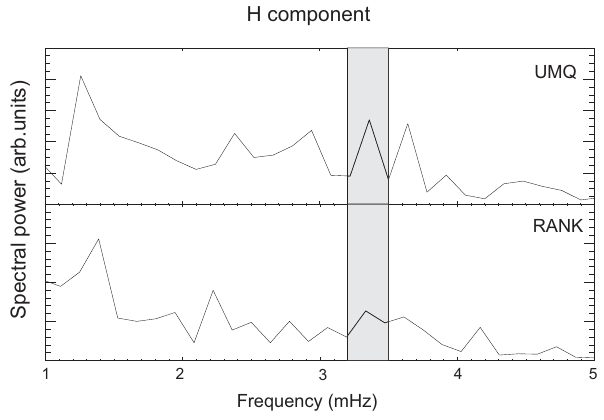
Figure 9. Event 2, the corresponding spectral power for the magne- tometer stations (UMQ (Greenland) and RANK (CARISMA)).